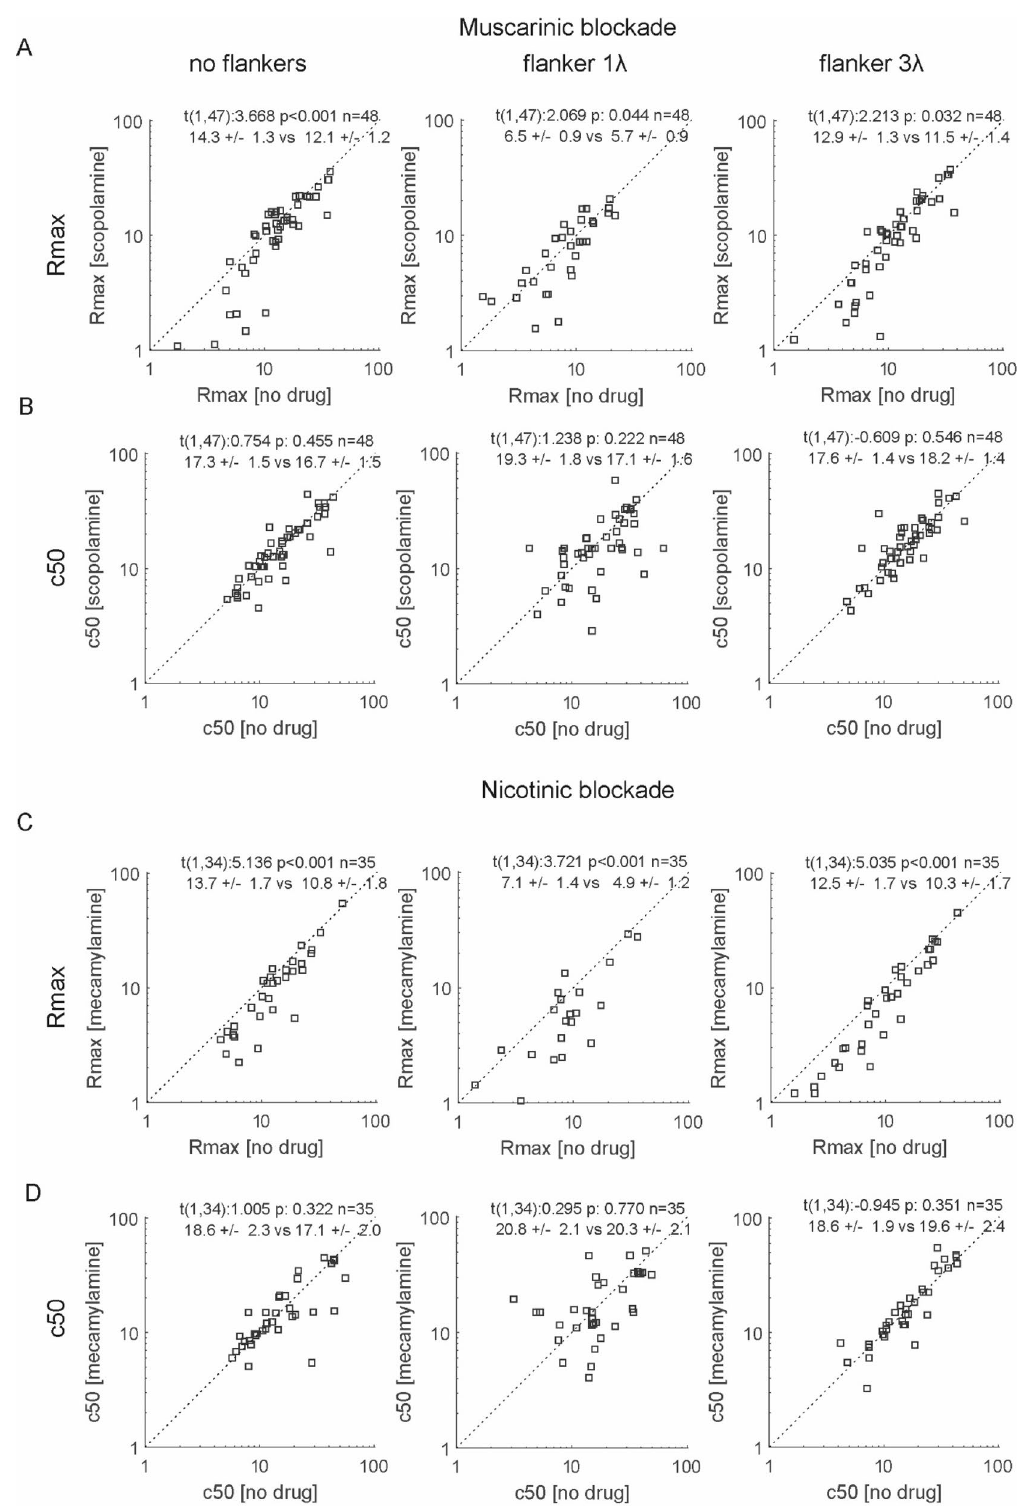
Figure 4. Effect of muscarinic and nicotinic blockade on Rmax and c50 at the population level for different flanker conditions. ( A ) Rmax in the no drug condition (x-axis) against scatterplot of Rmax of interest with scopolamine applied condition (y-axis). Left column shows results when no flankers were presented, middle column results for the flanker of 1λ, and right column shows results for the flanker of 3λ. Insets show paired t-test statistics along with the respective means ± S.E.M. of the distributions. ( B ) Same as A, but for slope instead of Rmax. ( C ) Same as A , but with mecamylamine as drug used. ( D ) same as B, but with mecamylamine as drug